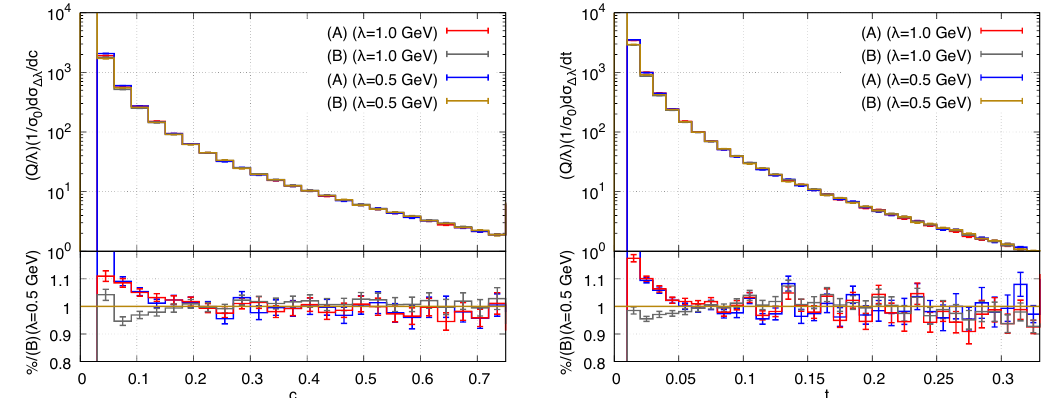
Figure 3 . Non-perturbative shift in the differential distributions for the C -parameter (left) and the thrust (right), obtained from eq. (5.34) (A), and from a full calculation in the large- n (B). Results are shown for the process γ ∗ → d ¯ dγ , with Q = 100 GeV and λ = 1 GeV, λ = 0 . 5 GeV.